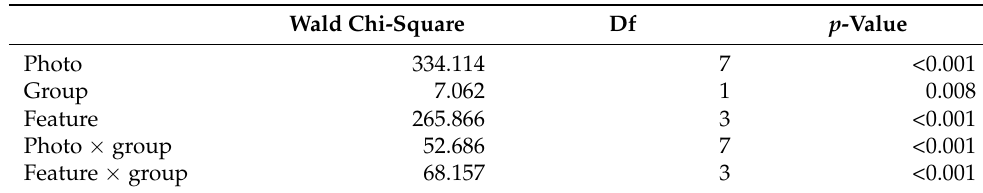
Table 16. Tests of model